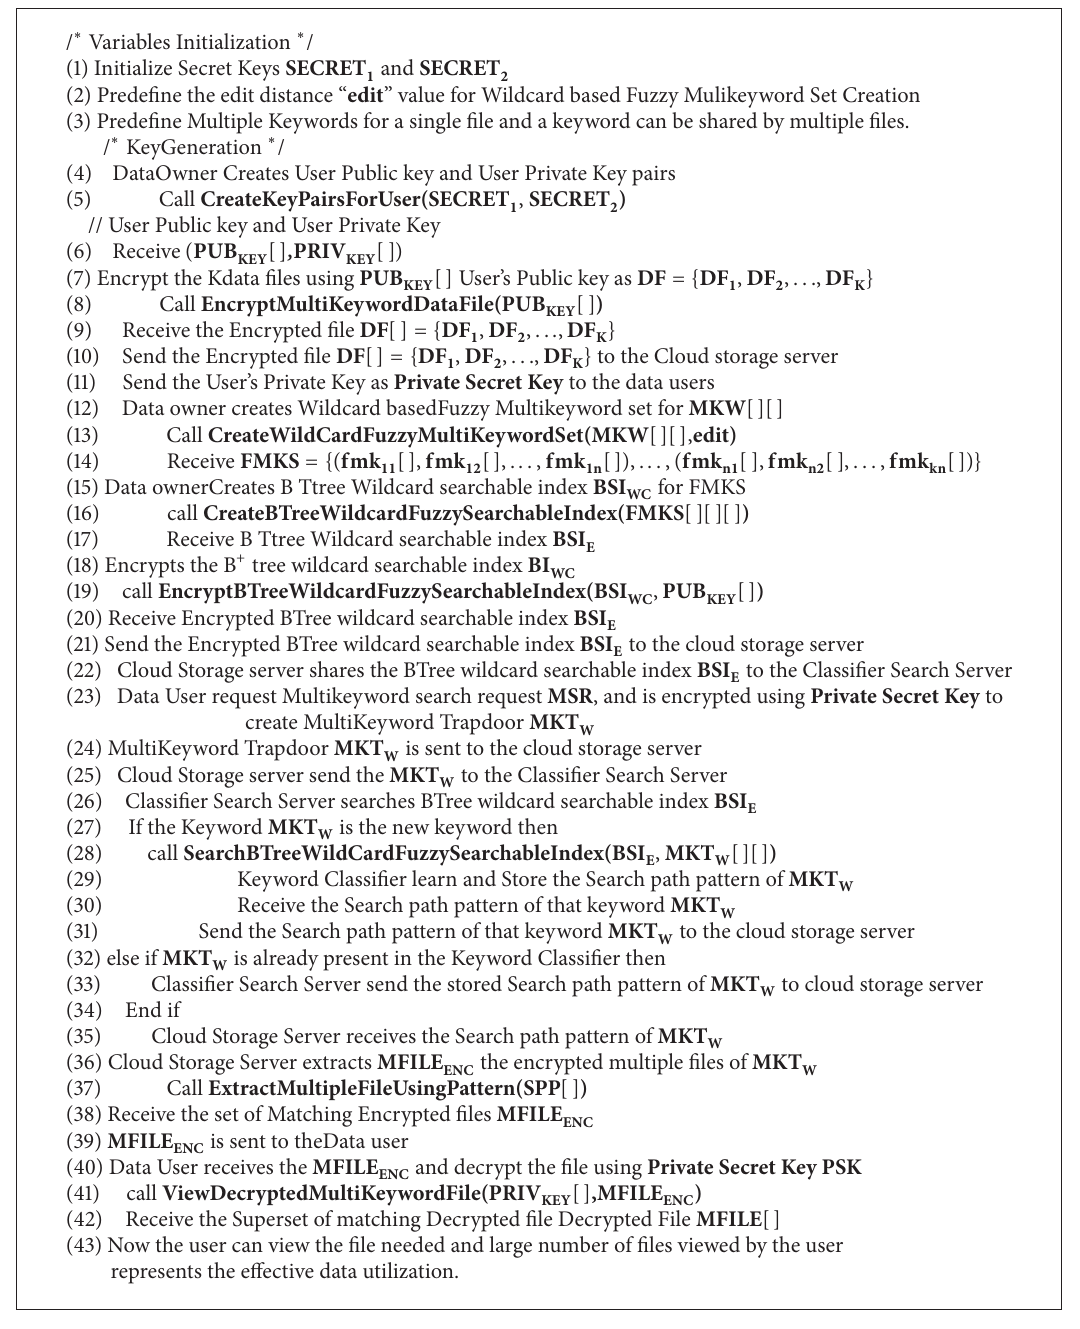
Algorithm 8 in Appendix to create BTree wild card fuzzy searchable index BSIWC for the wild card based